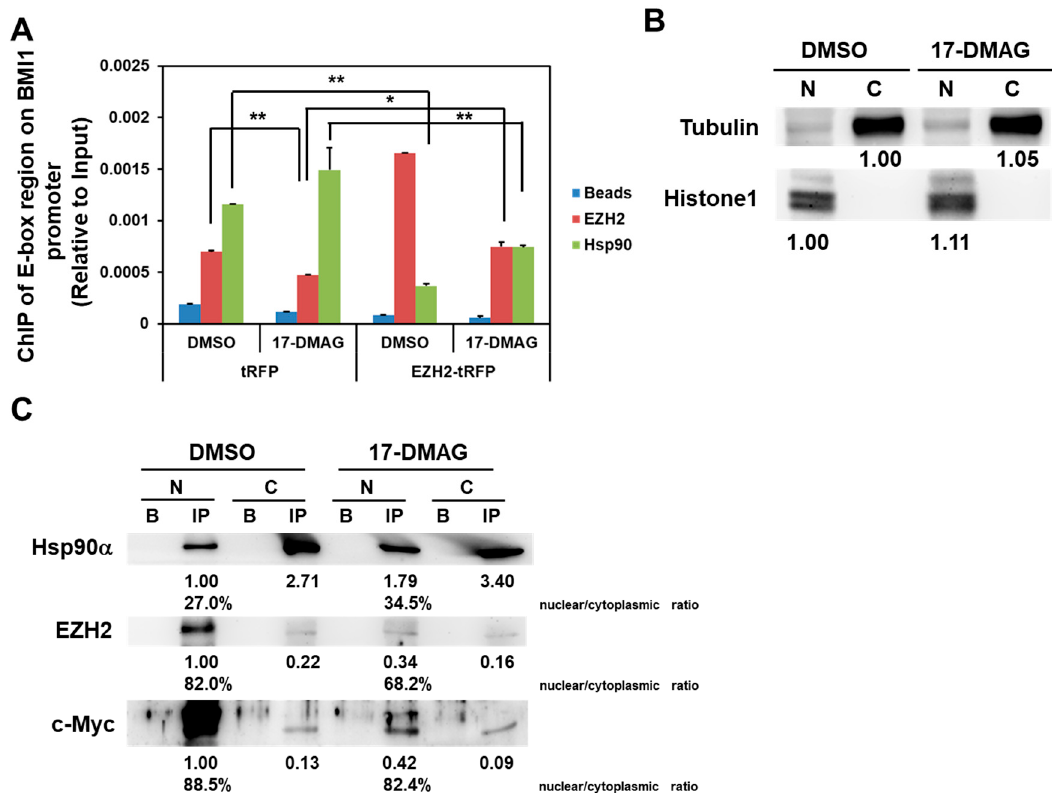
Figure 5. Hsp90 α facilitated the nuclear translocation of c-Myc and EZH2 to BMI1 promoter. ( A ) The binding of EZH2 or Hsp90 α on the E-Box region of BMI1 promoter in MDA-MB-231 mammospheres was determined by the ChIP method with anti-EZH2 or anti-Hsp90 α antibody, respectively. Data were presented as the relative expression level to input chromatin of each sample. * p < 0.05; ** p < 0.01; ( B ) The purity of the cytoplasmic or nuclear fraction from MDA-MB-231 mammospheres was confirmed by Western blot analysis of tubulin (cytoplasmic specific protein) or histone 1 (nuclei specific protein). An equal amount of nuclear or cytoplasmic proteins from DMSO- or 17-DMAG-treated MDA-MB-231 mammospheres was used for immunoprecipitation analysis; ( C ) The contents of Hsp90/ EZH2/c-Myc complex in cytoplasmic or nuclear fraction proteins of MDA-MB-231 mammospheres were determined by immunoprecipitation with anti-Hsp90 α antibody and analyzed by Western blot. N, nuclear; C, cytoplasmic; B, beads only; IP, immunoprecipitation.